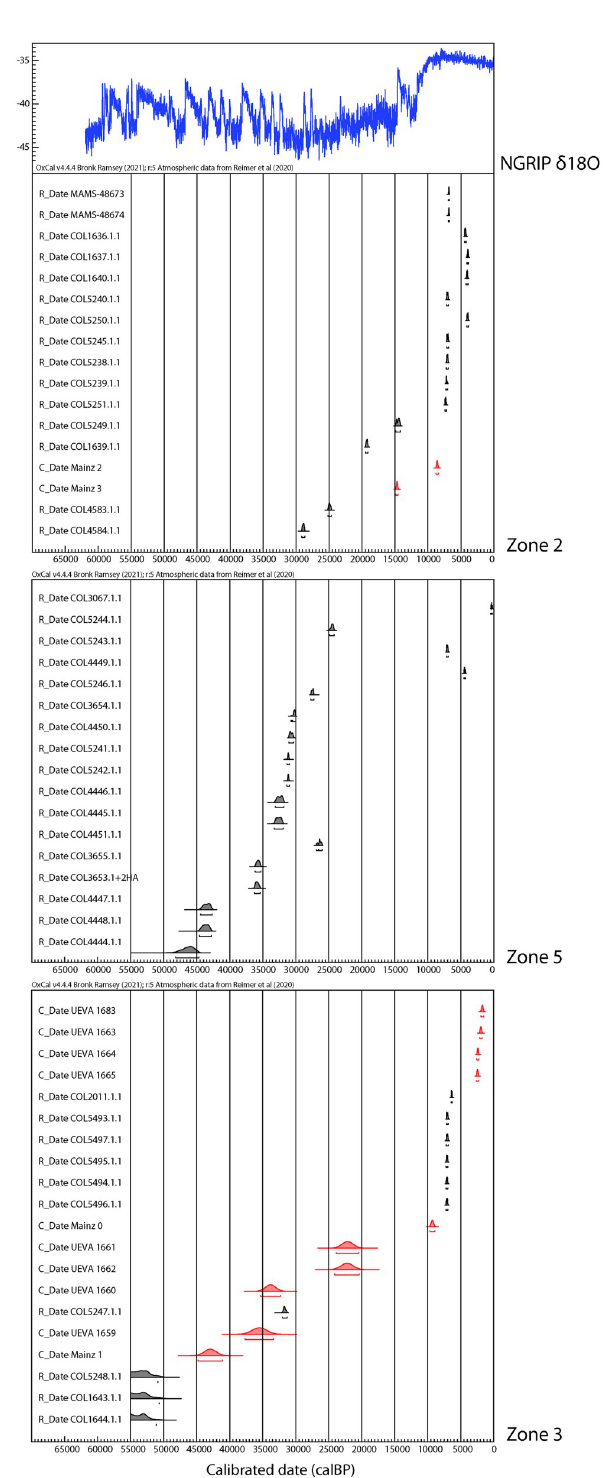
Fig 15. Radiocarbon dates for the Palaeolithic occupation of Cueva de Ardales.